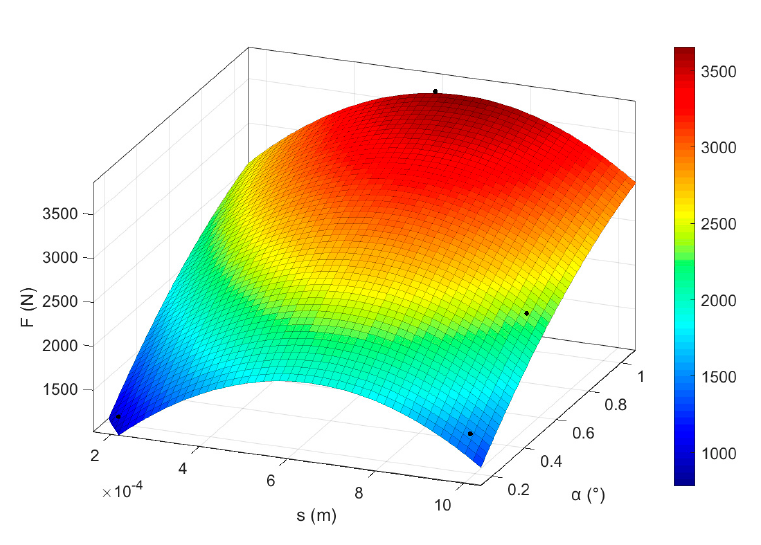
Figure 10. Response area chart for the total machining force F .